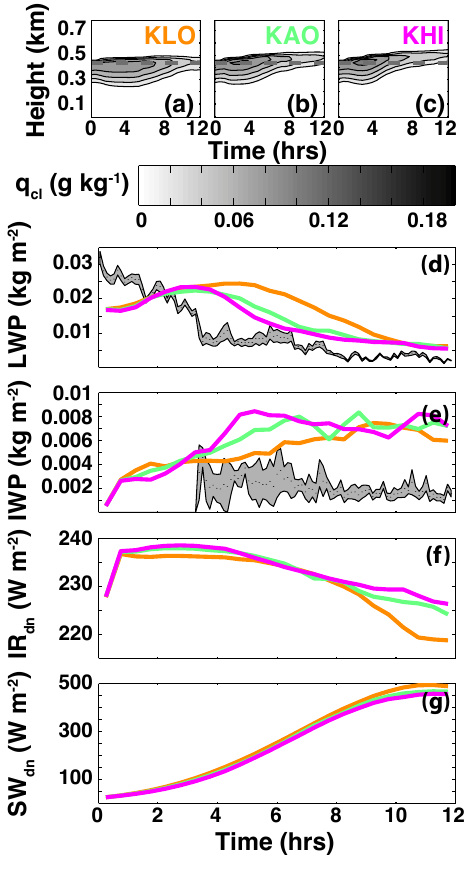
Fig. 12. An overview of simulation results assuming different aerosol concentrations. Included are domain-averaged time-height cross-sections of cloud water mixing ratio for the KLO (a) , KAO (b) and KHI (c) simulations. Additionally included are time series for domain-averaged liquid water path (d) , ice water path (e) , sur- face downwelling longwave radiation (f) , and surface downwelling shortwave radiation (g) . Grey shading in the liquid and ice water path plots represent the mean ± one standard deviation of observed values.